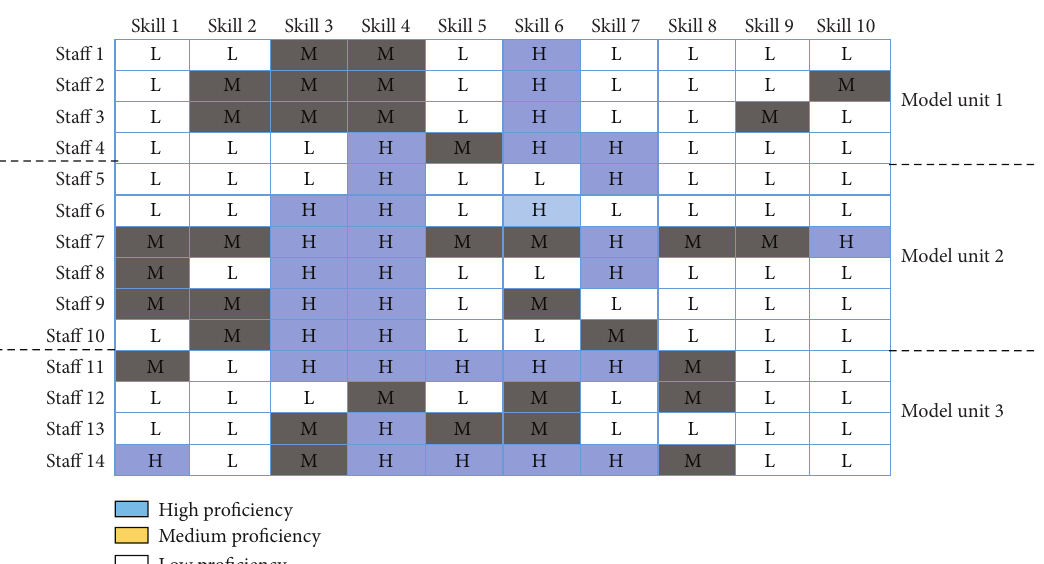
Figure 4: The overall process of the three model. The level distinction is shown in the bottom, and the model unit distinction is shown on the